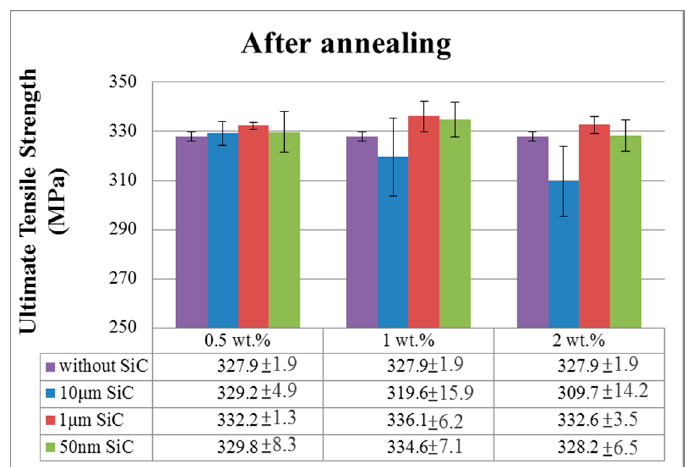
Figure 6. Ultimate strength of the AZ61/SiCp MMC extruded plates after annealing.